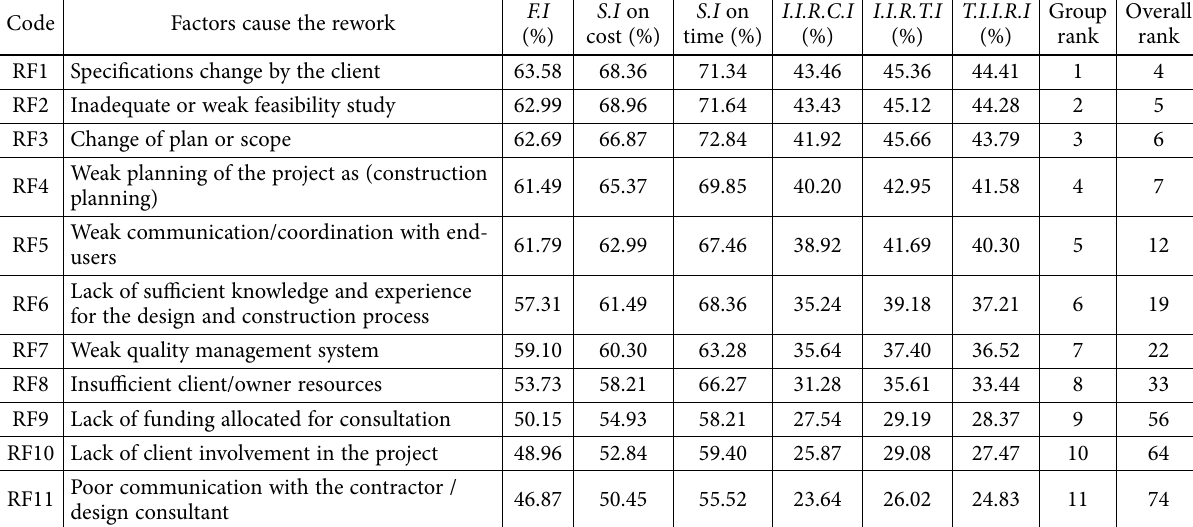
Table 4. Ranking the causes and impact of rework factors related to the client group